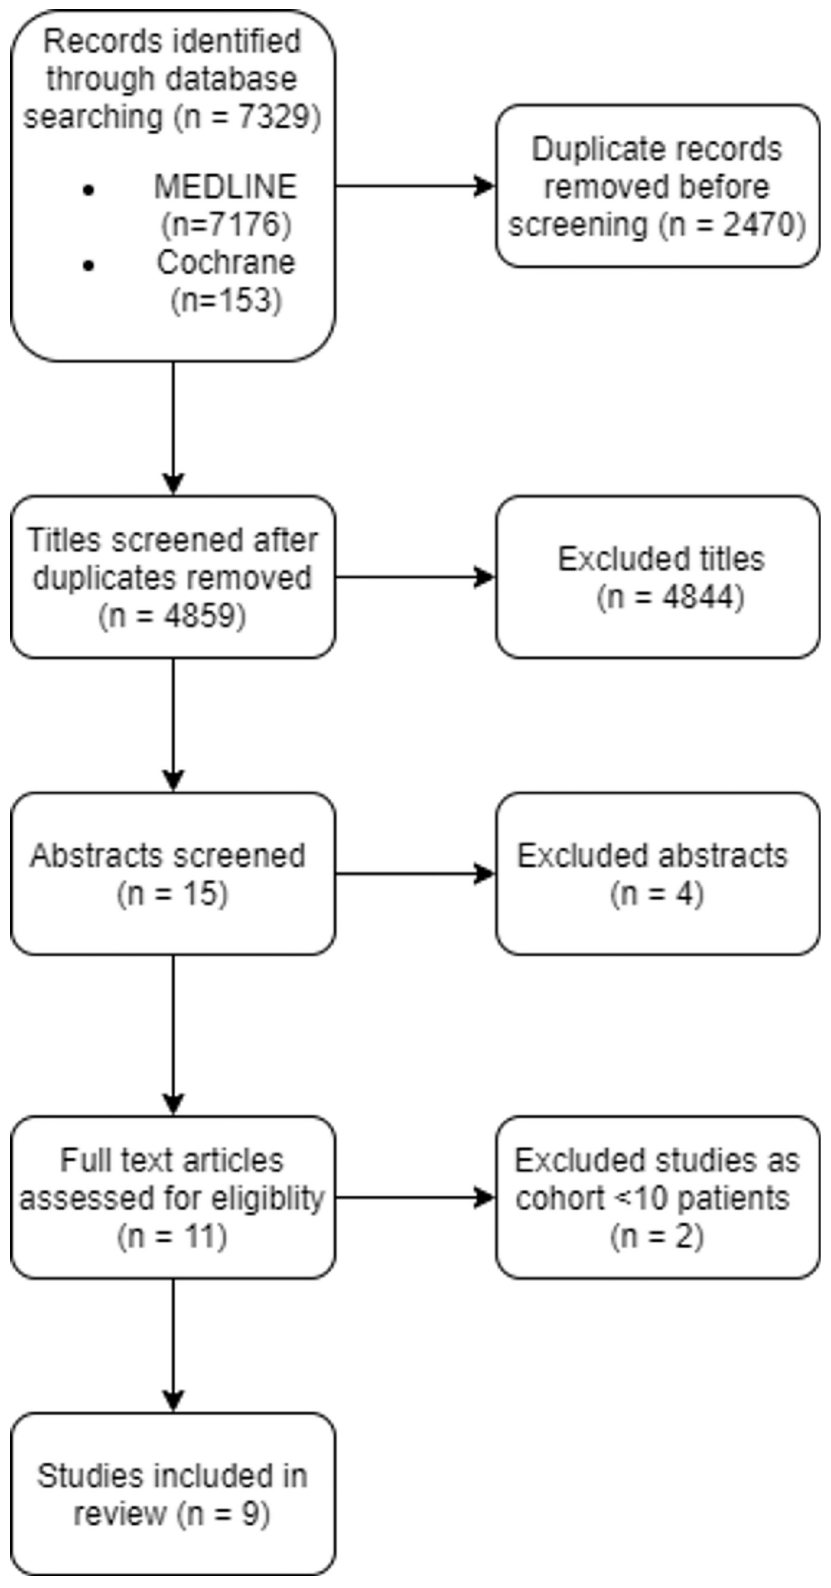
Fig 1. Search strategy according to PRISMA